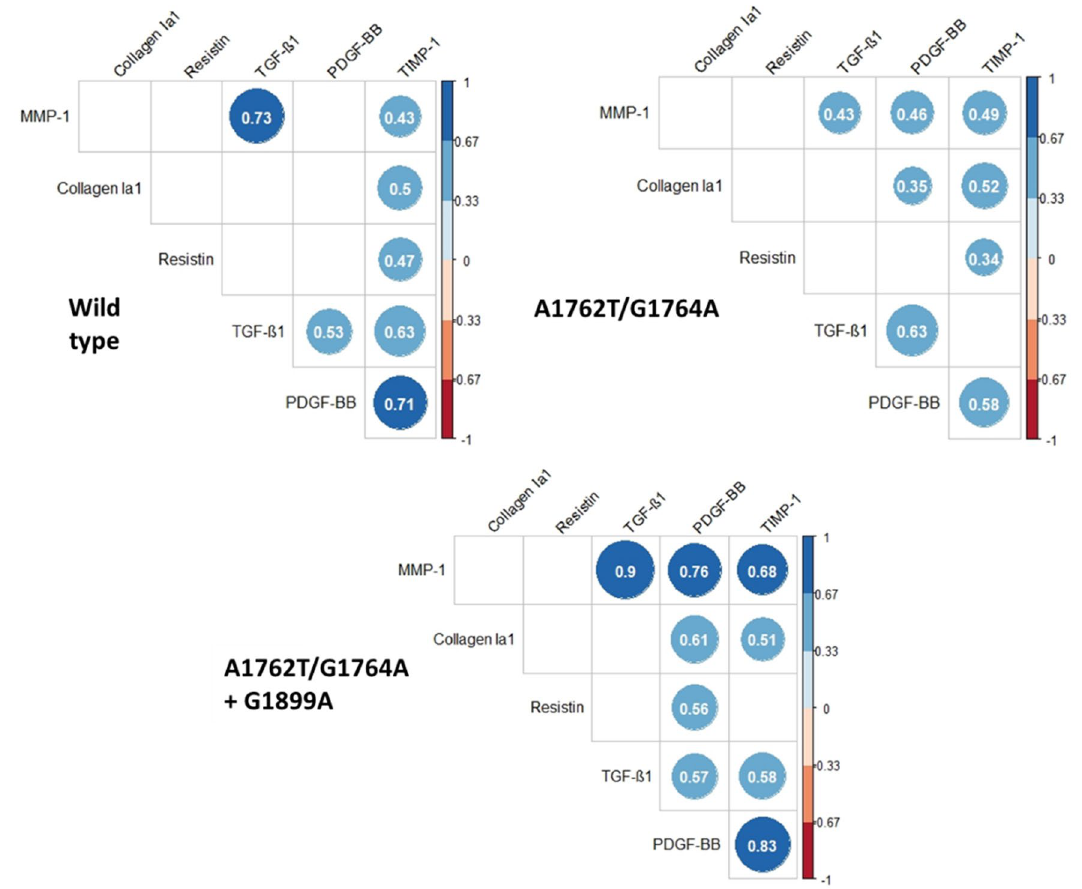
Figure 5. Correlations between the serum levels of liver markers (collagen IA1, resistin, TGF-β1, PDGF-BB, TIMP-1 and MMP-1) according to the mutation profile (wild type, A1762T/G1764A and A1762T/G1764A/ G1899A). For each type of mutant profile, the pairwise Spearman correlation between the markers was calculated. These correlations are presented in the correlation matrix. When a correlation was not significant, the case was left blank (for example, the correlation between MMP-1 and Collagen IA1 was not significant for all profile types). Significant correlations are represented by discs with exact values of the Spearman correlation. Blue discs indicate positive correlations and red discs indicate negative correlations. The scale on the right side of the matrix indicates the range of the correlation. All exact values of the Spearman correlation coefficients are presented in the Supplementary data (Supplementary Table